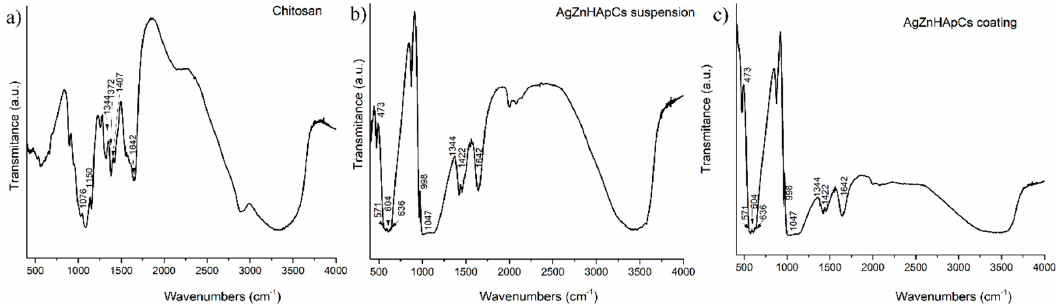
Figure 4. FTIR spectra of chitosan ( a ), AgZnHApCs suspension ( b ) and AgZnHApCs coating ( c ).